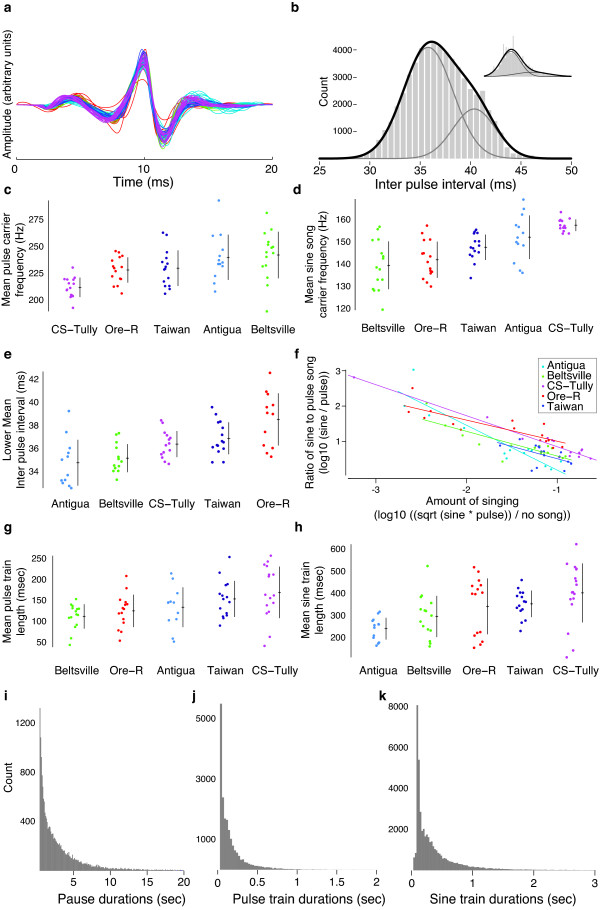
Statistics of D. melanogaster song. (a) Mean (per individual) re-scaled pulse shapes from five wild-type strains: Antigua = light blue; Beltsville = green; CS-Tully = purple; Oregon-R = red; Taiwan = dark blue. The same colors indicate strains in later panels. (b) Histogram of inter-pulse intervals over the entire dataset. Inset illustrates the distribution for one individual. A two-component Gaussian mixture model (dark line) and the two Gaussian components (light lines) are shown fitted to the data. (c, d) The average pulse (c) and sine train (d) carrier frequencies vary between individuals and amongst strains. (e) The mean inter-pulse interval, here shown for the lower component of a Gaussian mixture model, showed considerable variation amongst strains. (f) The relative amounts of sine and pulse trains were treated as a "three-way choice' - between sine train, pulse train, and no song - and plotted as recommended by Schilling et al. [45]. This method reveals that flies that produced more song overall sang proportionately fewer sine trains relative to pulse trains. In addition, strains displayed significant heterogeneity in the relative amounts of sine and pulse trains that they produced. (g,h) Both pulse train length (g) and sine train length (h) exhibit variation amongst strains. (i-k) The duration of all pauses between song bouts (i), the duration of pulse trains (j), and the duration of sine trains (k) each exhibit extensive variation.